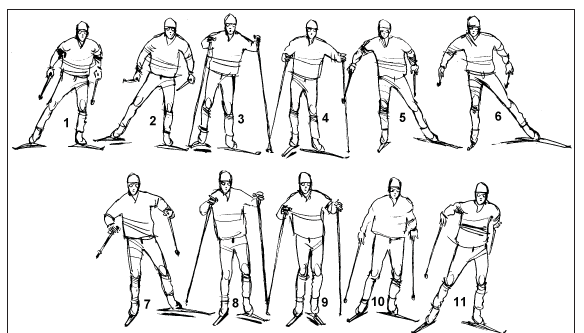
Figure 3. Timing of the monitored muscles (on cross-country